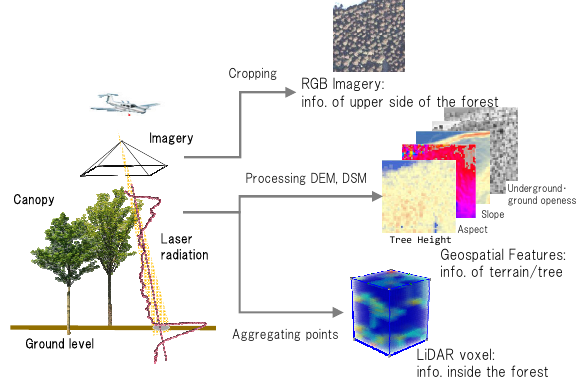
Figure. 6 Data pre-processing